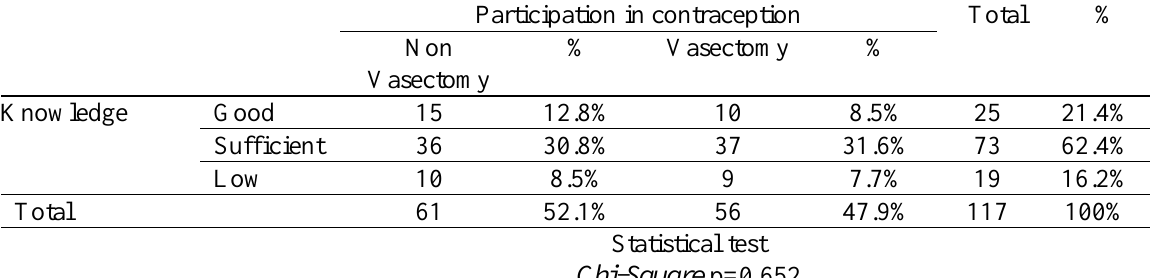
Table 1 The correlation of knowledge and vasectomy selection using a Chi-Square